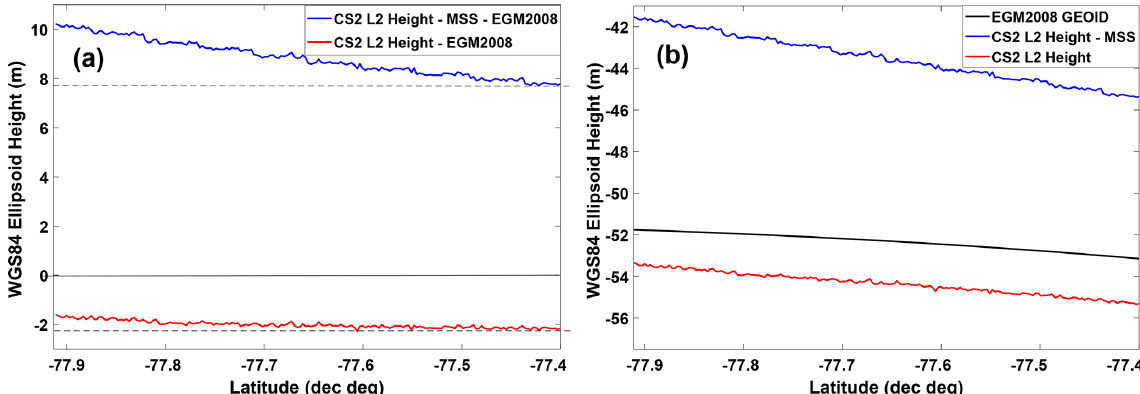
Figure A1. Comparison of CryoSat-2 heights from the Level 2 SARIn product and the effects of de-trending with the Earth Gravitational Model 2008 (EGM 2008) geoid (Pavlis et al., 2012) over 55km of open ocean in McMurdo Sound on 17 March 2011. (a) Surface 1: CS2 height with the MSS applied and all ocean corrections applied (red); surface 2: CS2 height with the MSS not applied and all ocean corrections applied (blue); and surface 5: EGM 2008 surface (black). (b) CS2 height with the MSS not applied and de-trended for the EGM 2008 geoid (blue), and surface 6: CS2 height with the MSS applied and all ocean corrections applied and then de-trended for the EGM 2008 geoid (red). All heights are given relative to the WGS84 ellipsoid. Dashed horizontal lines are included in panel (b) to highlight the different gradients in the